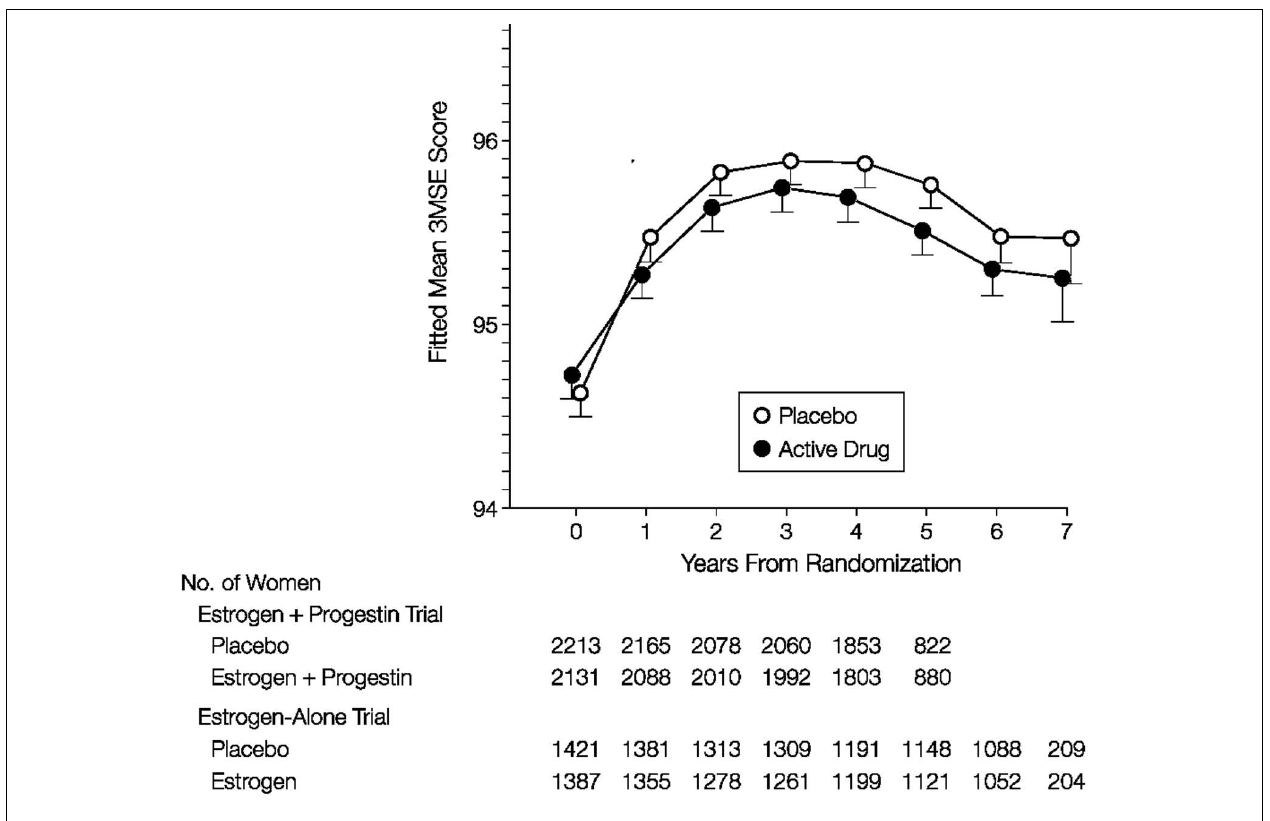
FIGURE 3 |The effect of estrogen alone on Cognitive Function in theWomen’s Health Initiative (taken from Espeland etal.,